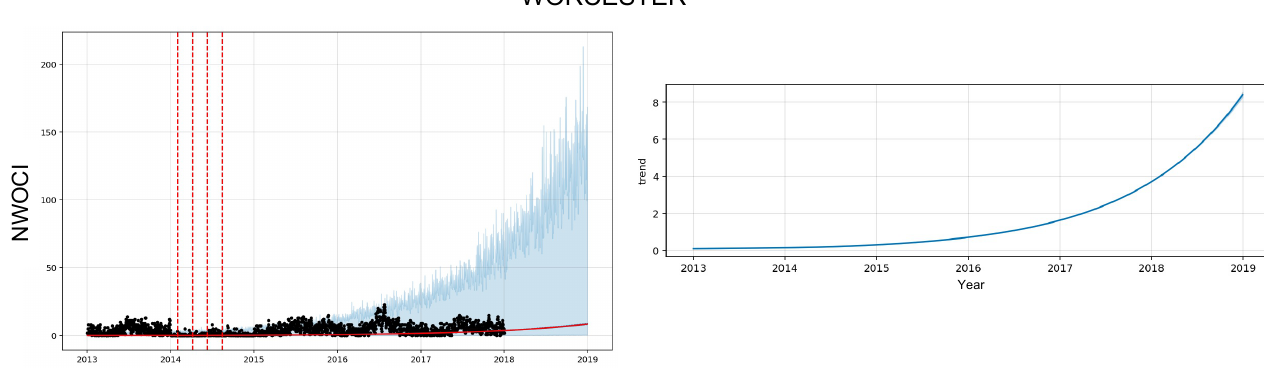
Figure A12. Left : One year forecast (2018 test data) from Prophet-BU Model for Suffolk county in MA. N.B: The solid blue line shows the average forecast while the solid red line shows the observed trend of NWOCI and the light blue region represents the 80% confidence interval for the forecast uncertainty. Also, the scatter points represent the historical values in the training data (2013–2017). Right : Corresponding trend decomposition from Prophet-BU Model.